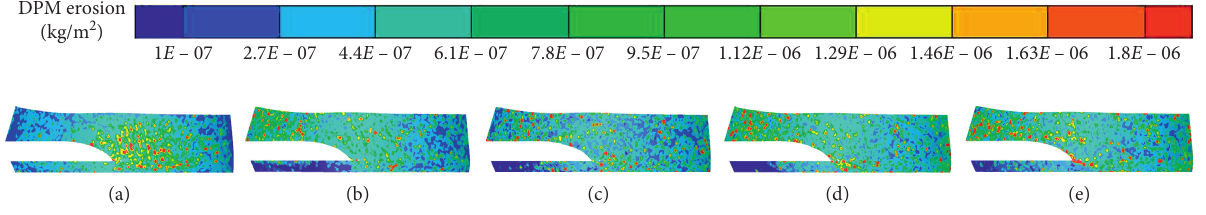
Figure 9: Pressure surface wear clouds at different particle sizes. (a) d � 0.048mm, (b) d � 0.106mm, (c) d � 0.15mm, (d) d � 0.27mm, and (e) d �